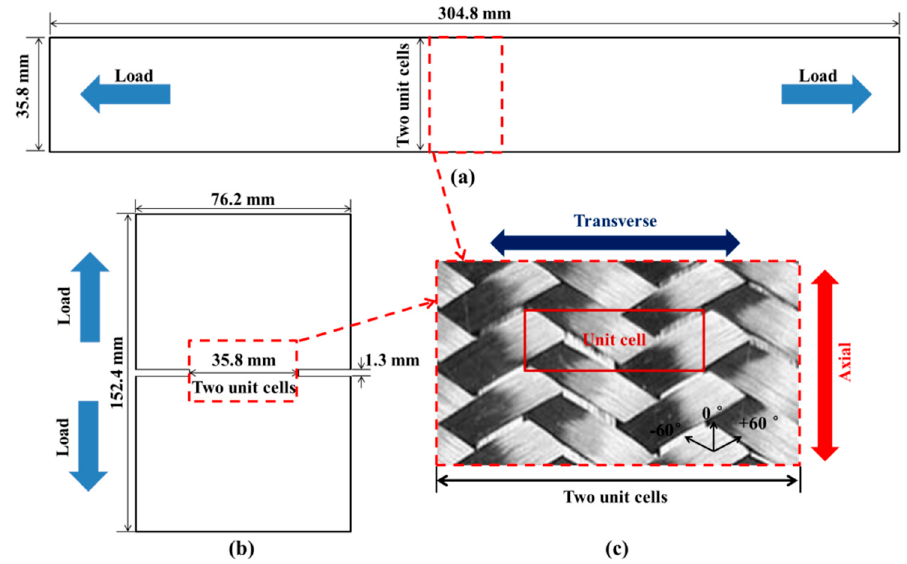
Figure 1. ( a ) Dimensions of the straight-side coupon. ( b ) Dimensions of double edge notch specimen. ( c ) Representative architecture of triaxially-braided composite.